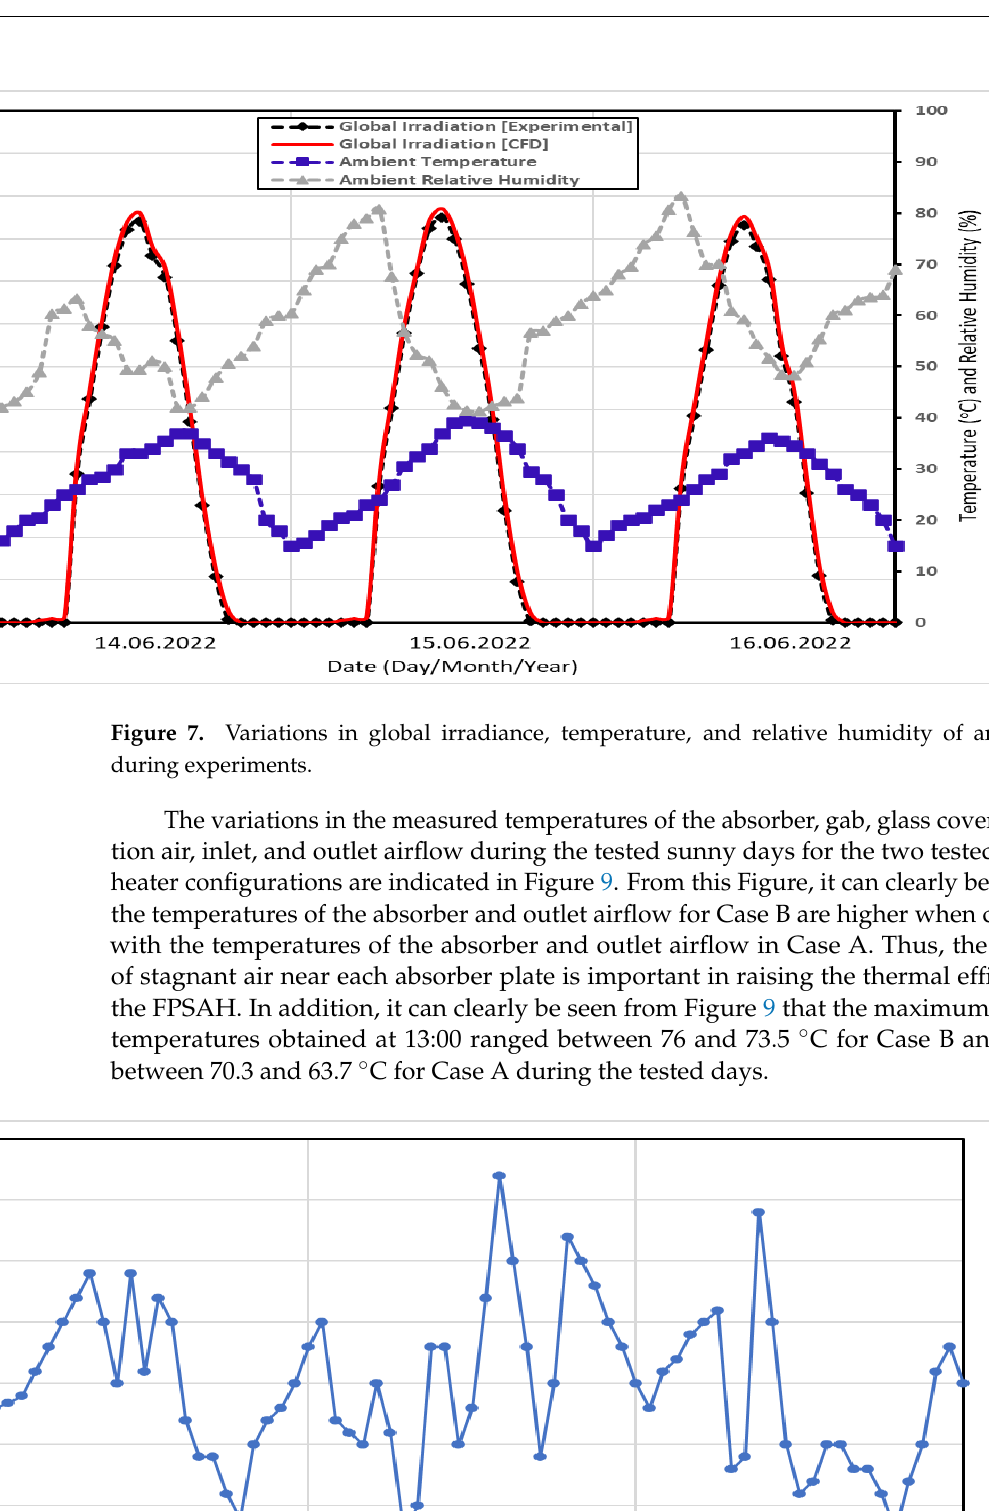
Figure 8. Variations in ambient air velocities during experiments.